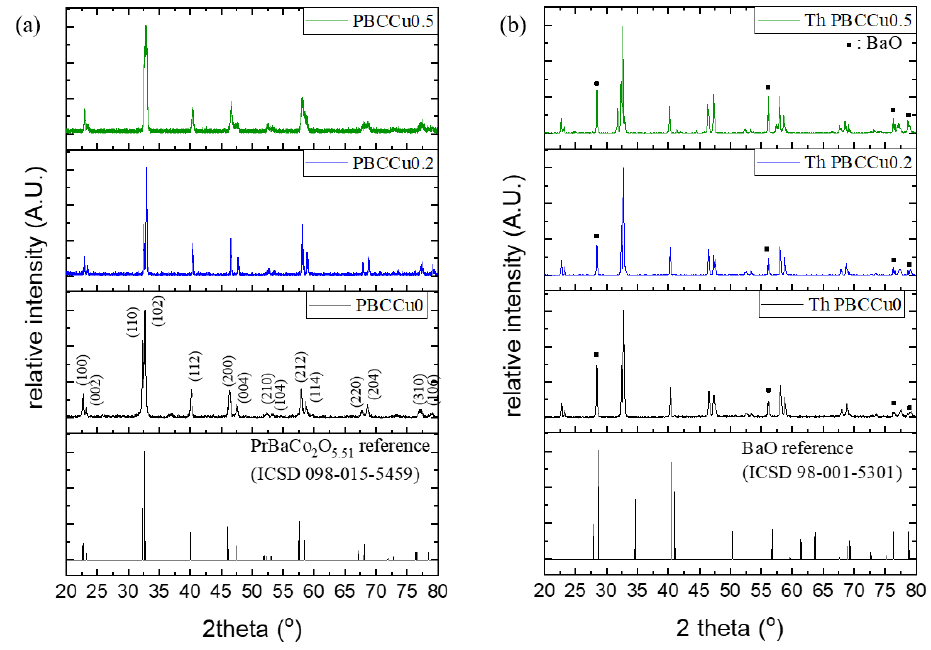
Figure 1. XRD patterns of PBCCu x : ( a ) Pristine and ( b ) After applying thermal stress for 100 h on 1050 °C.